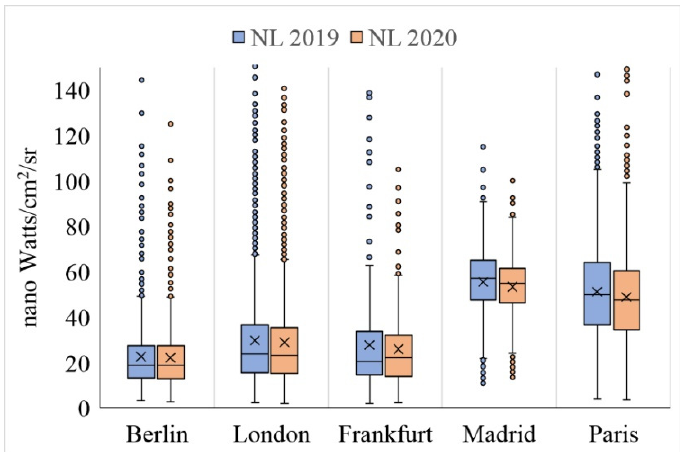
Figure 12. NL characteristics in the studied cities during 2019 (blue) and 2020 (red). Table 5. Results of the paired samples t-test for NLs data in the studied cities for the two time pe- riods.